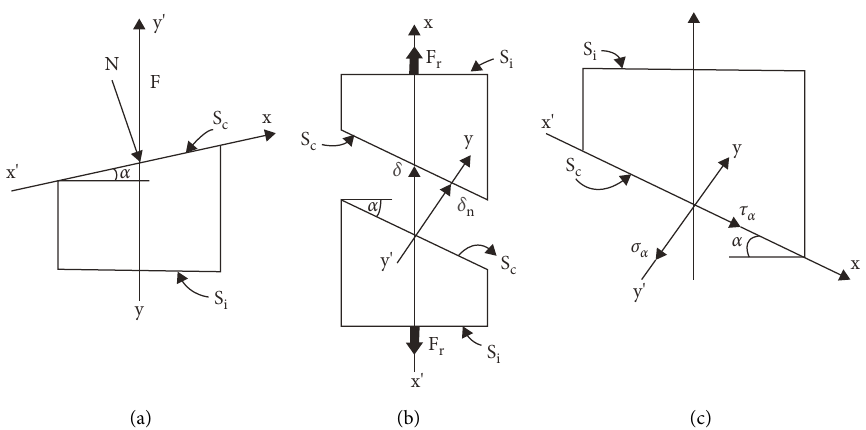
Figure 8: Illustration of the butting angle: (a) applied load, (b) different surfaces and displacement, and (c) normal stress at the cut and tangential.